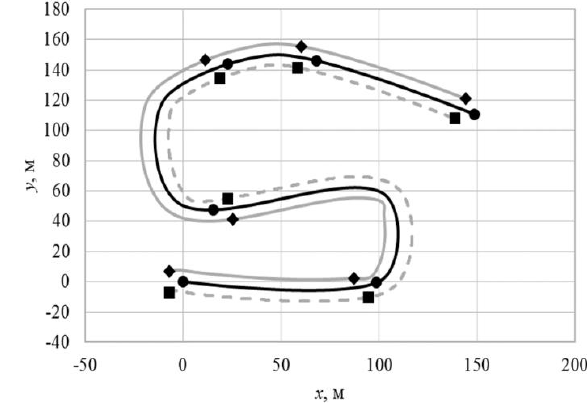
Figure 4. The resulting trajectory of the movement of three robots within the group